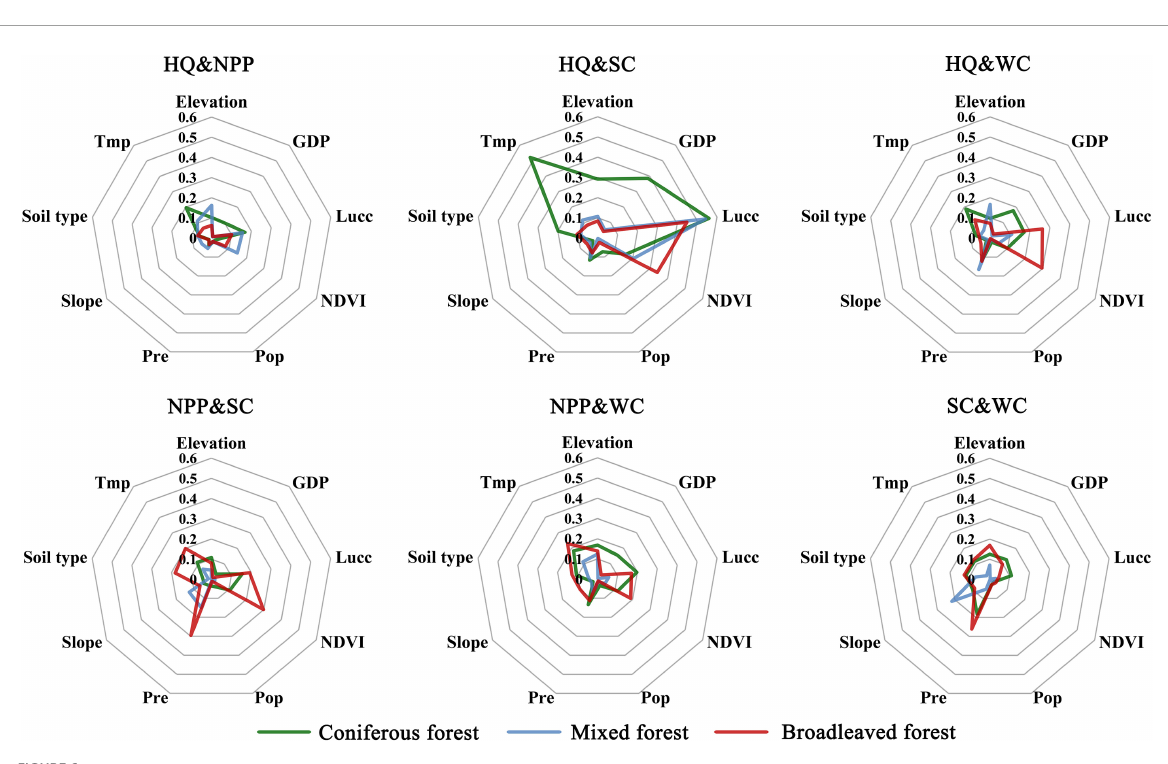
the continuous improvement of forest ecosystems during the second phase (Zhao et al., 2017; Dong et al., 2021; Yang et al.,